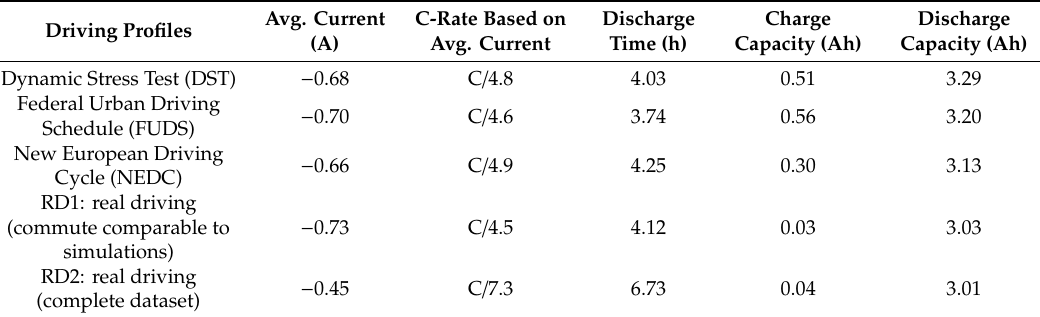
Figure 1. The power profiles for the dynamic stress test (DST), Federal Urban Driving Schedule (FUDS), New European Driving Cycle (NEDC), and real driving-1 (RD1) cycles. Table 1. Properties of the driving profiles during discharge.